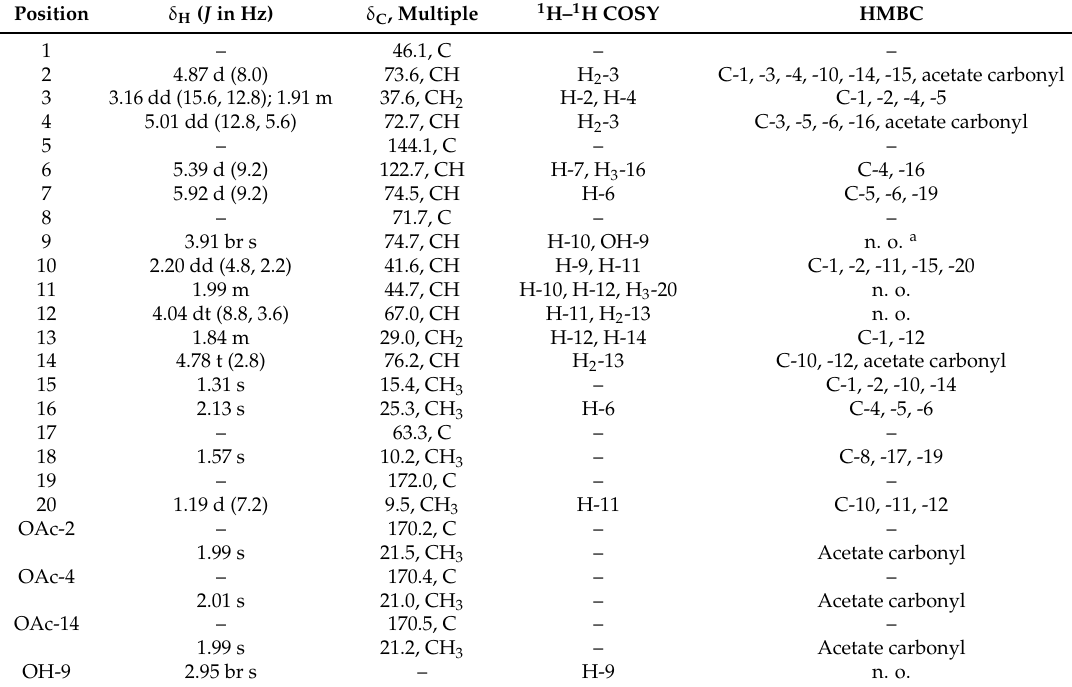
Table 6. 1 H (400 MHz, CDCl 3 ) and 13 C (100 MHz, CDCl 3 ) NMR data and 1 H– 1 H COSY and HMBC correlations for briarane 6 .